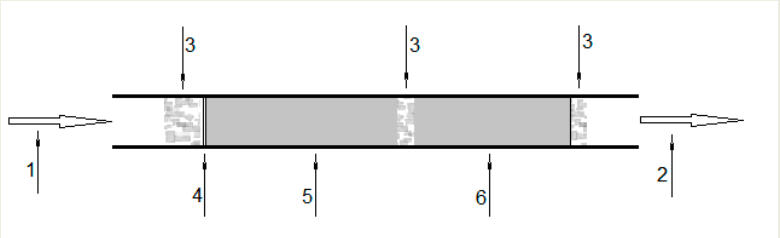
Figure 2. Glass tube for sampling (1) airflow direction, (2) air outlet, (3) glass fiber, (4) glass fiber filter, (5) silica gel first layer (400 mg), (6) silica gel second layer (200 mg) (drawing of the author).